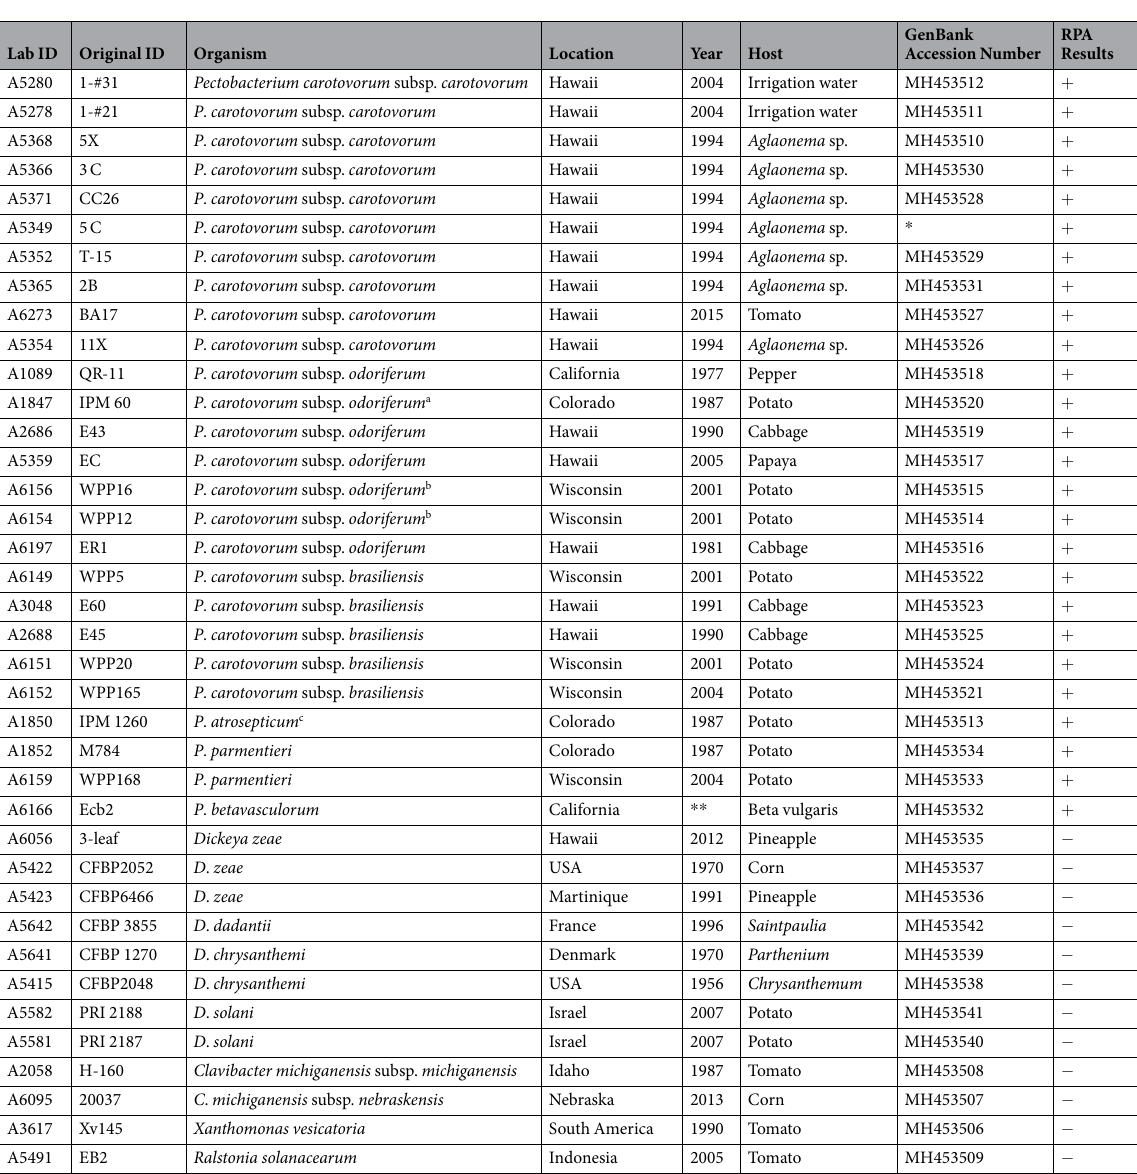
Table 1. Bacterial strains used to validate the Recombinase Polymerase Amplification (RPA) method for specific detection of soft rot-causing plant bacteria in the genus Pectobacterium . + Positive result; − negative result; * sequencing quality was not high, therefore, the sequence was not submitted to NCBI GenBank; ** year of isolation is not known; a originally (1987) identified as Erwinia carotovora subsp. carotovora; b originally (2001) identified as Pectobacterium carotovorum subsp. carotovorum; c originally (1987) identified as Erwinia carotovora subsp. atroseptica . Year represents either year of isolation or year of receiving the strain in our